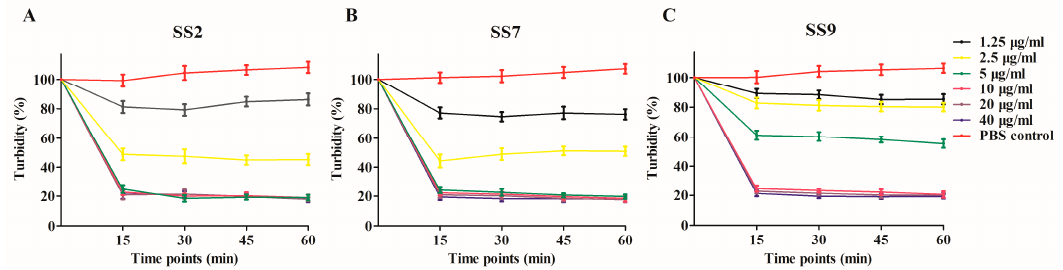
Figure 2. The turbidity reduction of Streptococcus suis ( A) S. suis serotype 2 (SS2), ( B ) S. suis serotype 7 (SS7), and ( C ) S. Suis serotype 9 (SS9) after treatment with the indicated concentrations of Ply5218. The data shown are means ± SEMs for at least three independent